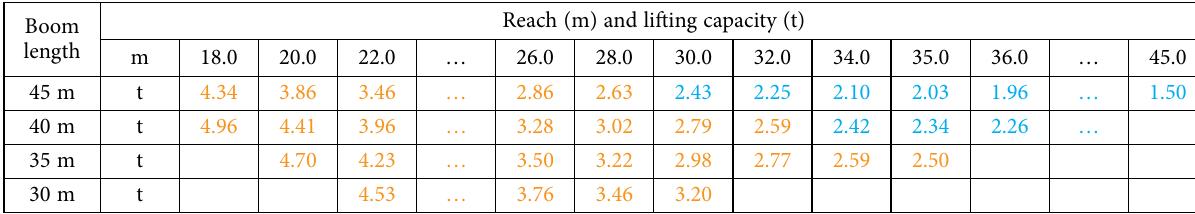
Table 1. Mechanism work